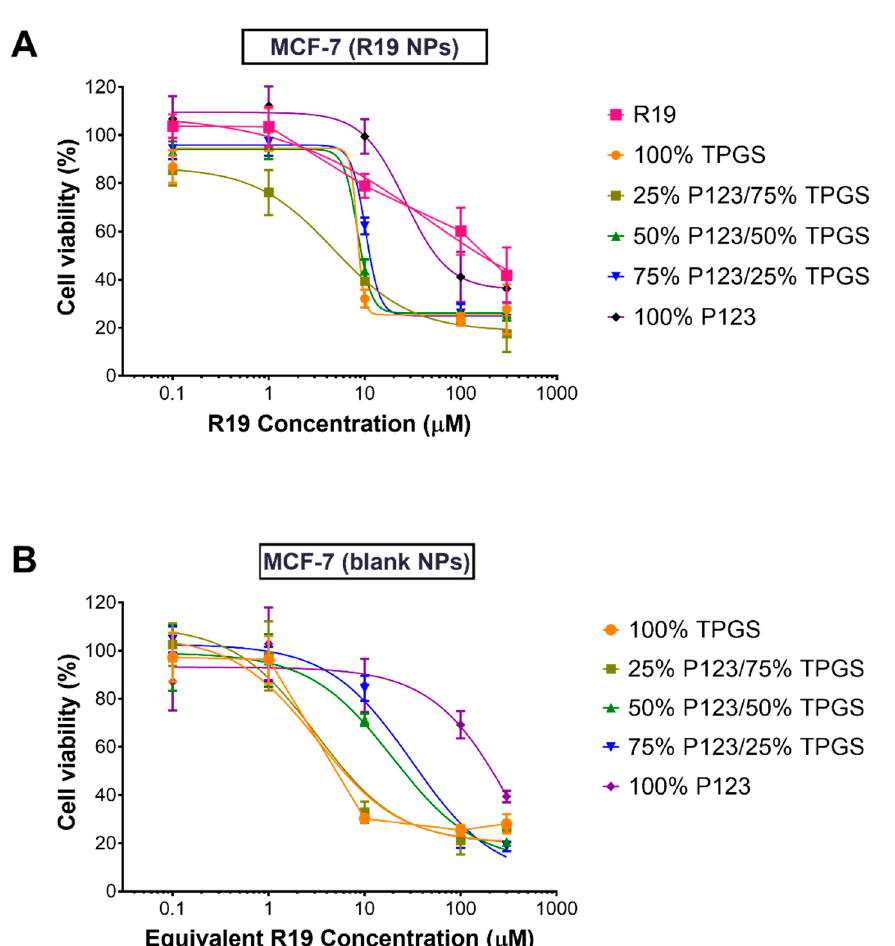
Figure 8. Percentage viability of MCF-7 cells treated with ( A ) R19 and R19-loaded NPs and ( B ) blank NPs for 48 h ( n = 5).